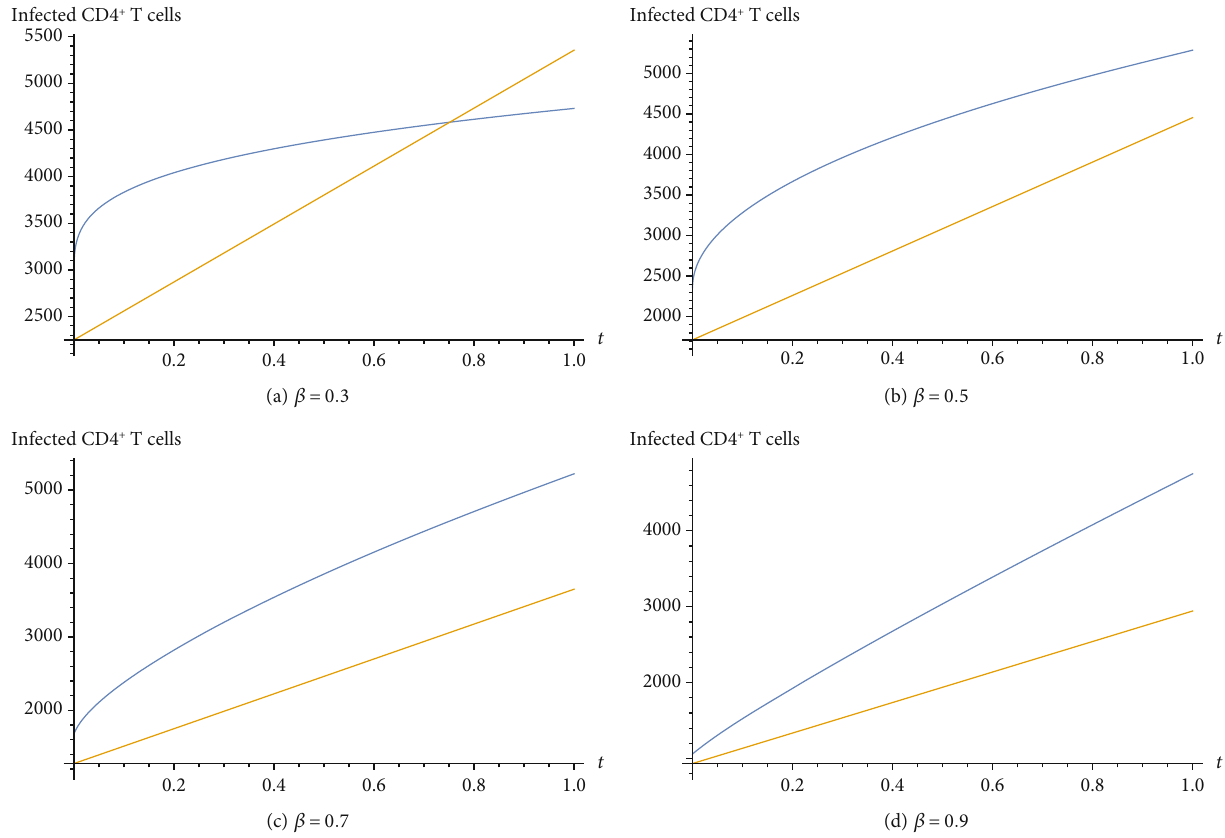
Figure 4: The comparison of the behavior of infected CD4 + T cells in Caputo-Fabrizio and Atangana Baleanu sense for di ff erent order fractional derivatives, where blue colour represents graph for ABC operator and orange represents graph for CF